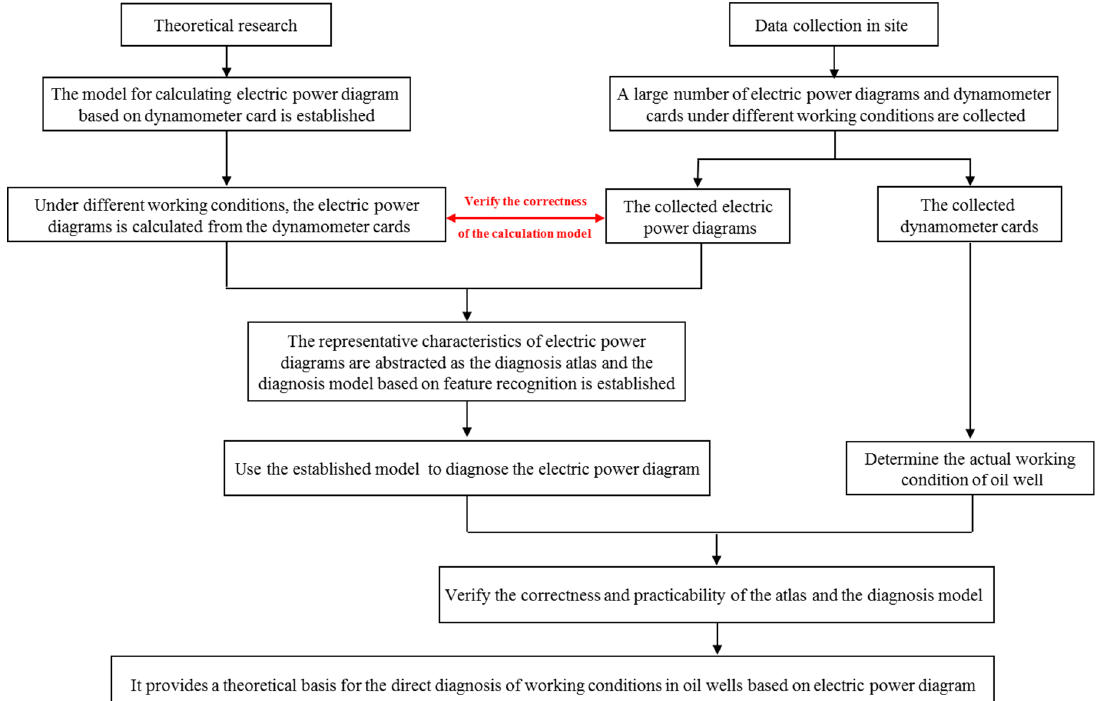
Figure 2. Flow chart of technical ideas.